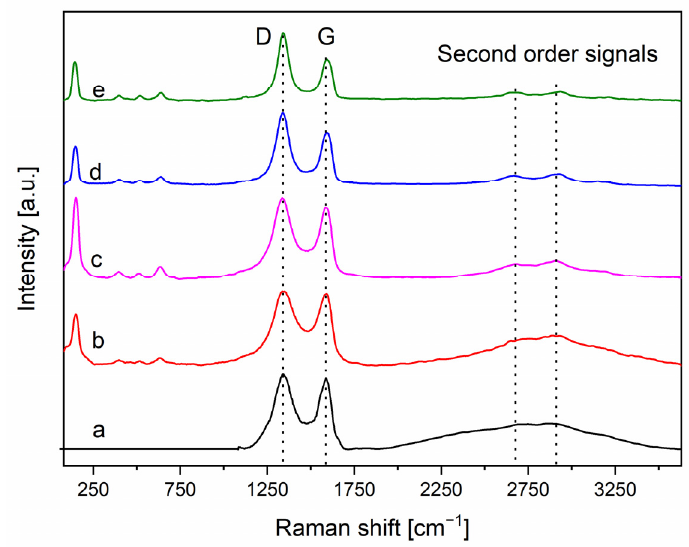
Figure 4. Raman spectra of the examined samples: black line- GO; red line - TiO 2 -GO; pink line - TiO 2 -rGO thermal; blue line - TiO 2 -rGO solar and green line -TiO 2 -rGO UV. At low Raman shift (150 cm − 1 , 397 cm − 1 , 518 cm − 1 , and 640 cm − 1 ), there are the typical P25 peaks related to E g , B 1g , A 1g +B 1g , and E g vibrational modes, respectively. After the